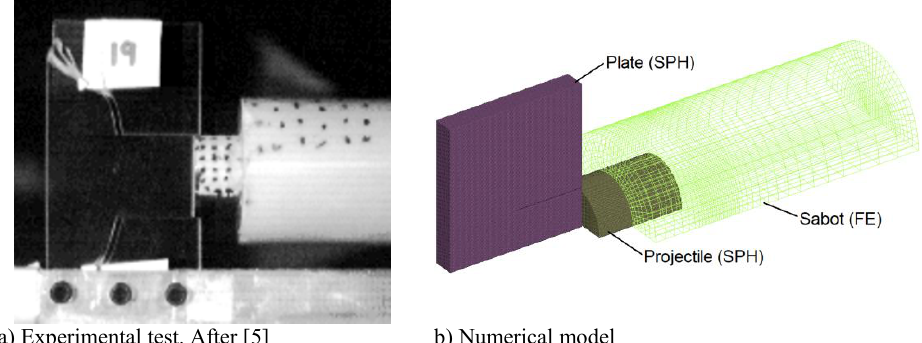
Fig. 3. Experimental configuration and numerical